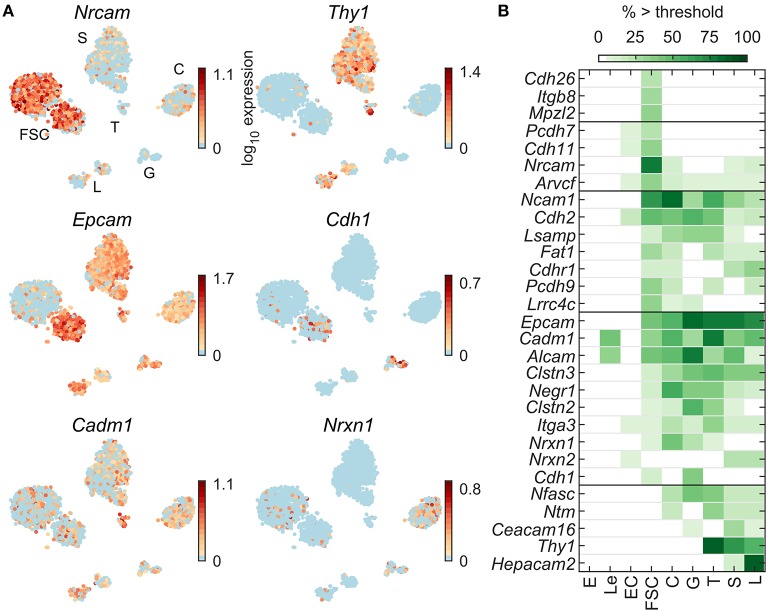
Expression of genes encoding cell adhesion molecules. (A) tSNE map showing expression of select members of cell adhesion gene families: immunoglobulin-like (Nrcam, Thy1, Cadm1), cadherins (Cdh1), and type-I membrane proteins containing EGF-like domains (Epcam, Nrxn1). (B) Percentage of cells per type expressing cell adhesion genes above threshold. From a manually selected list of cell adhesion molecule genes, including the list of HGNC cell adhesion molecule gene family members, 87 were expressed in at least 5% of cells in at least one cell type (Table 2) and all 29 pituitary-dominant genes are shown.